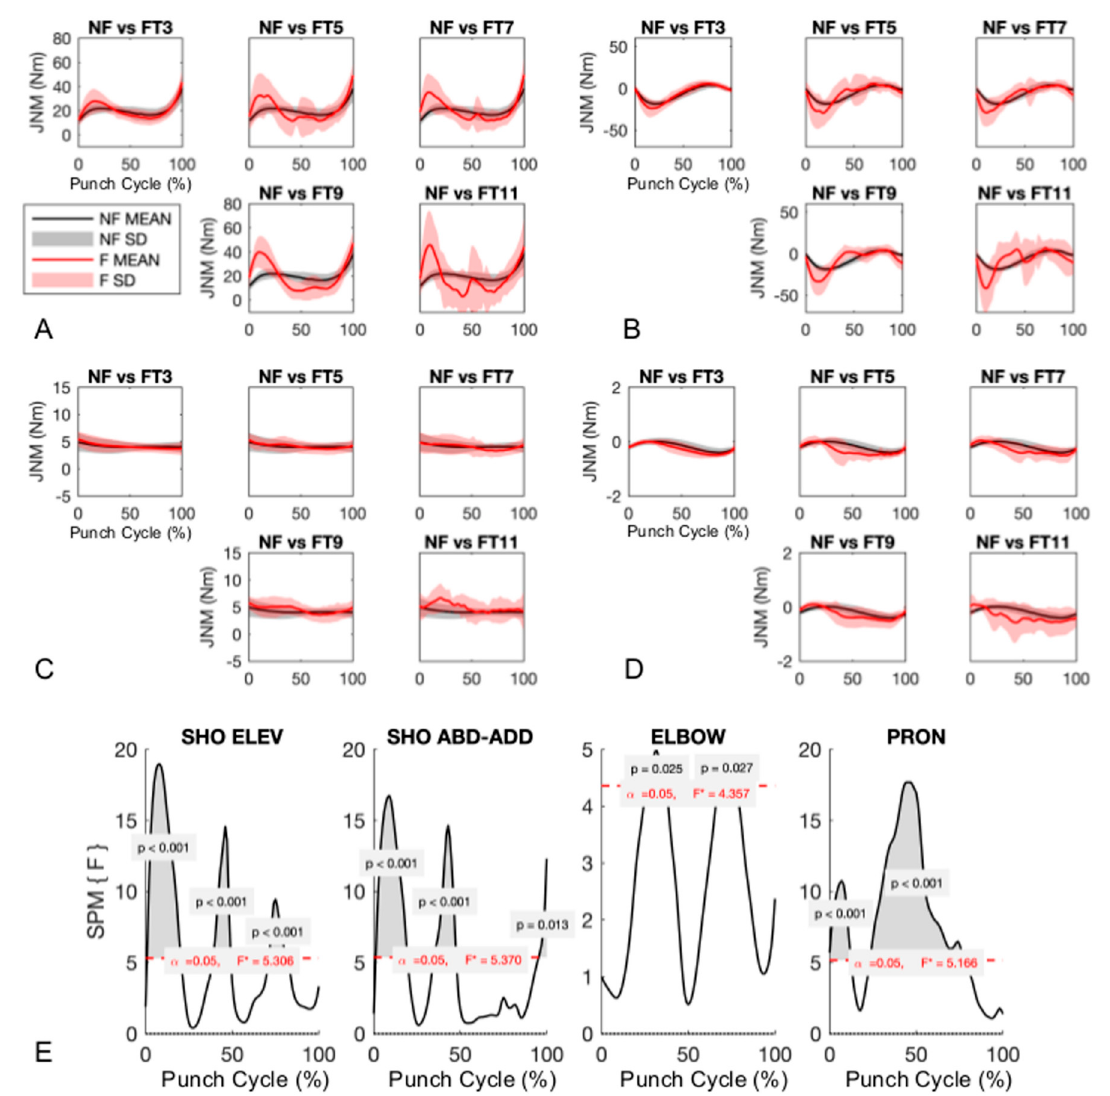
Figure 5. ( A ) Shoulder elevation, ( B ) shoulder abduction/adduction, ( C ) elbow flexion/extension, and ( D ) elbow pronation/supination moments. Non-fatigued (NF) (black solid lines and bands) plotted against 5 different fatigued (FTX) trials (red lines and bands). ( E ) Results from within-subject one-way ANOVA using a statistical parametric mapping approach. Periods showing a statistically significant difference are highlighted by grey areas above the critical F statistic. The simulations were carried out from the beginning of the pre-impact phase (0%) to the end of the pre-impact phase (100%).